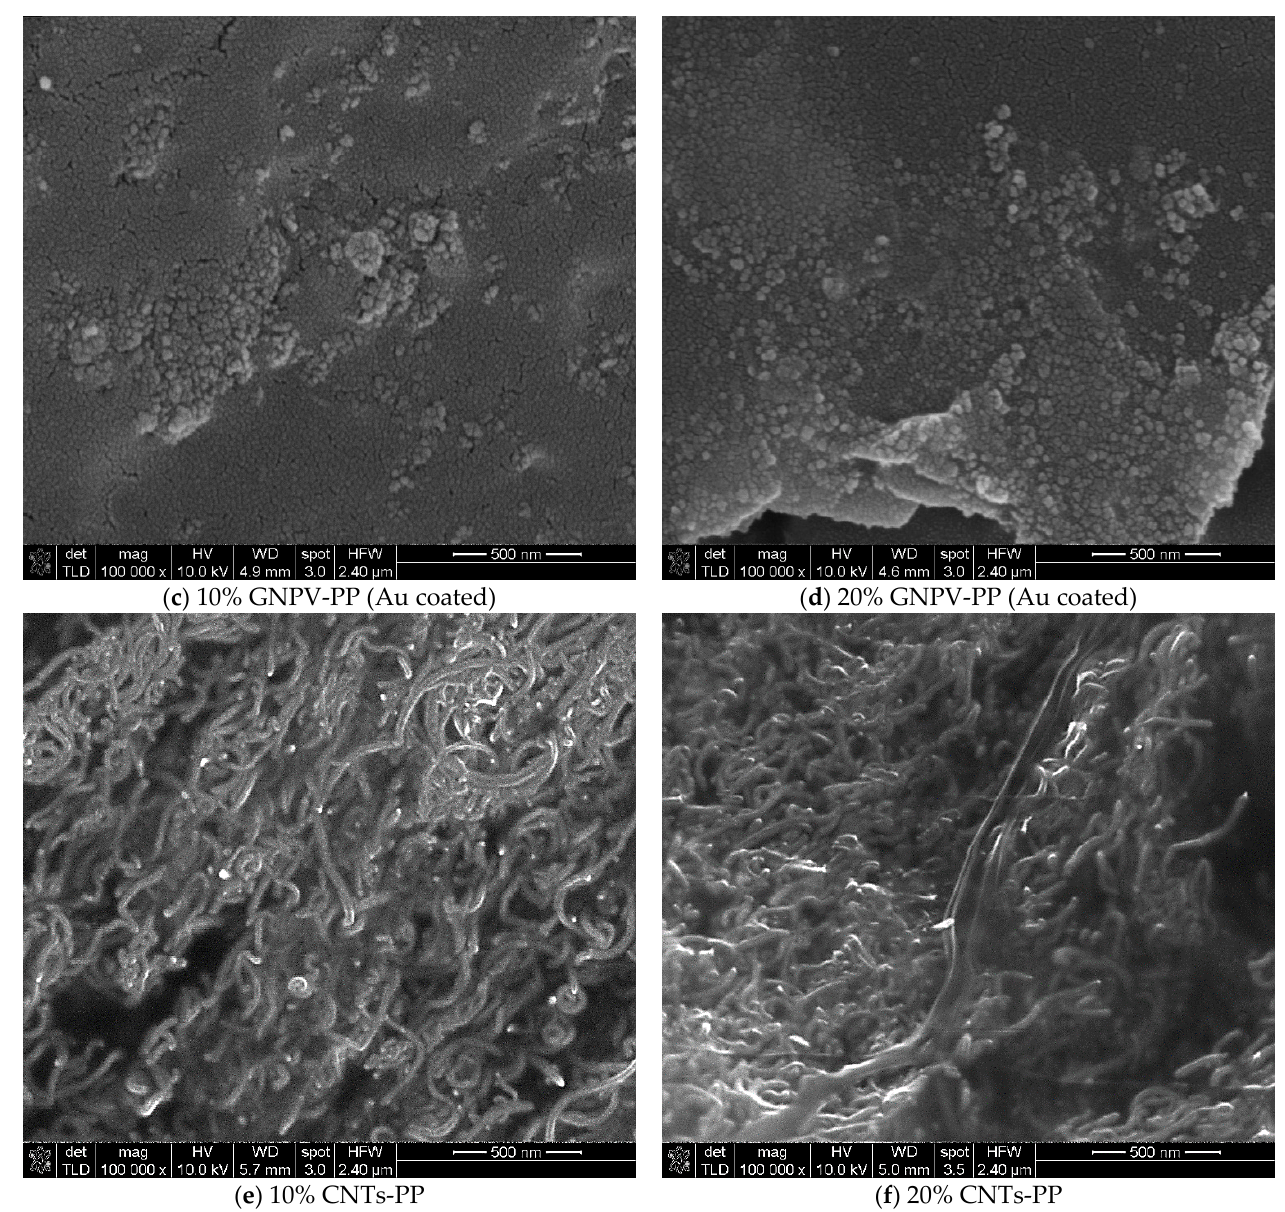
Figure 6. SEM characterization of ( a ) 10% GNPS-PP, ( b ) 20% GNPS-PP, ( c ) 10% GNPV-PP, ( d ) 20%